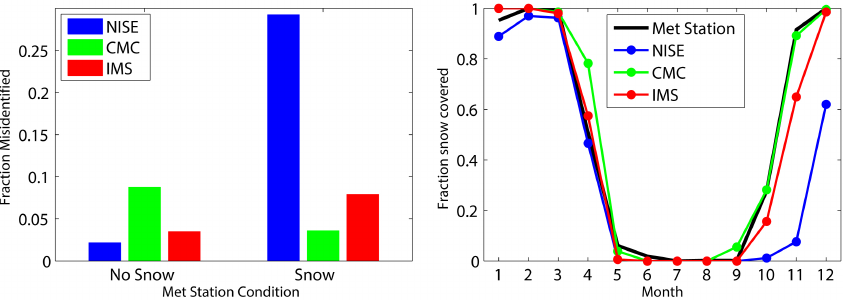
Fig. 4. Left: fraction of days in which the snow cover product misidentified the presence of snow on the ground, relative to the determination from the meteorological station. Right: monthly mean fraction of days with snow as determined to be on the ground according to four sources of data. These results are averaged over 2000–2011 and combined results from the Fort McMurray and Mildred Lake meteorological stations.